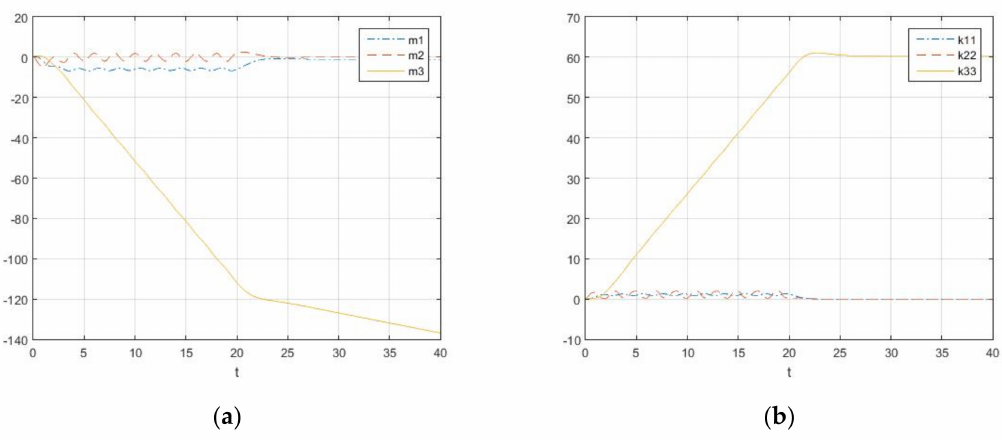
Figure 10. ( a ) Graphs m 1 , m 2 , m 3 at α = 180 ◦ , N = 10; ( b ) Graphs k 11 , k 22 , k 33 at α = 180 ◦ , N =